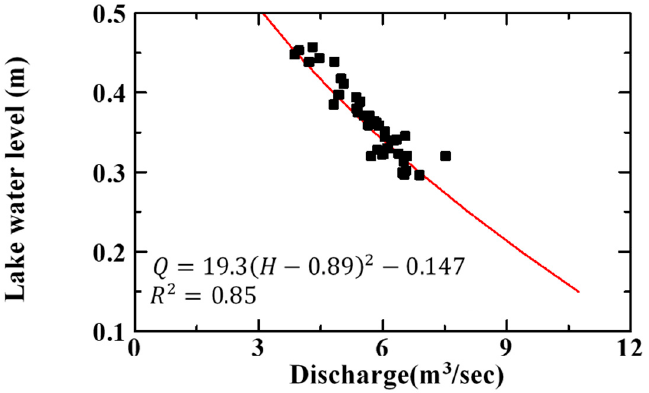
Figure 7. The relationship between the lake water level and the reverse flow from the lagoon to the lake calculated from the gradient between the lower WL observatory and seawater level.